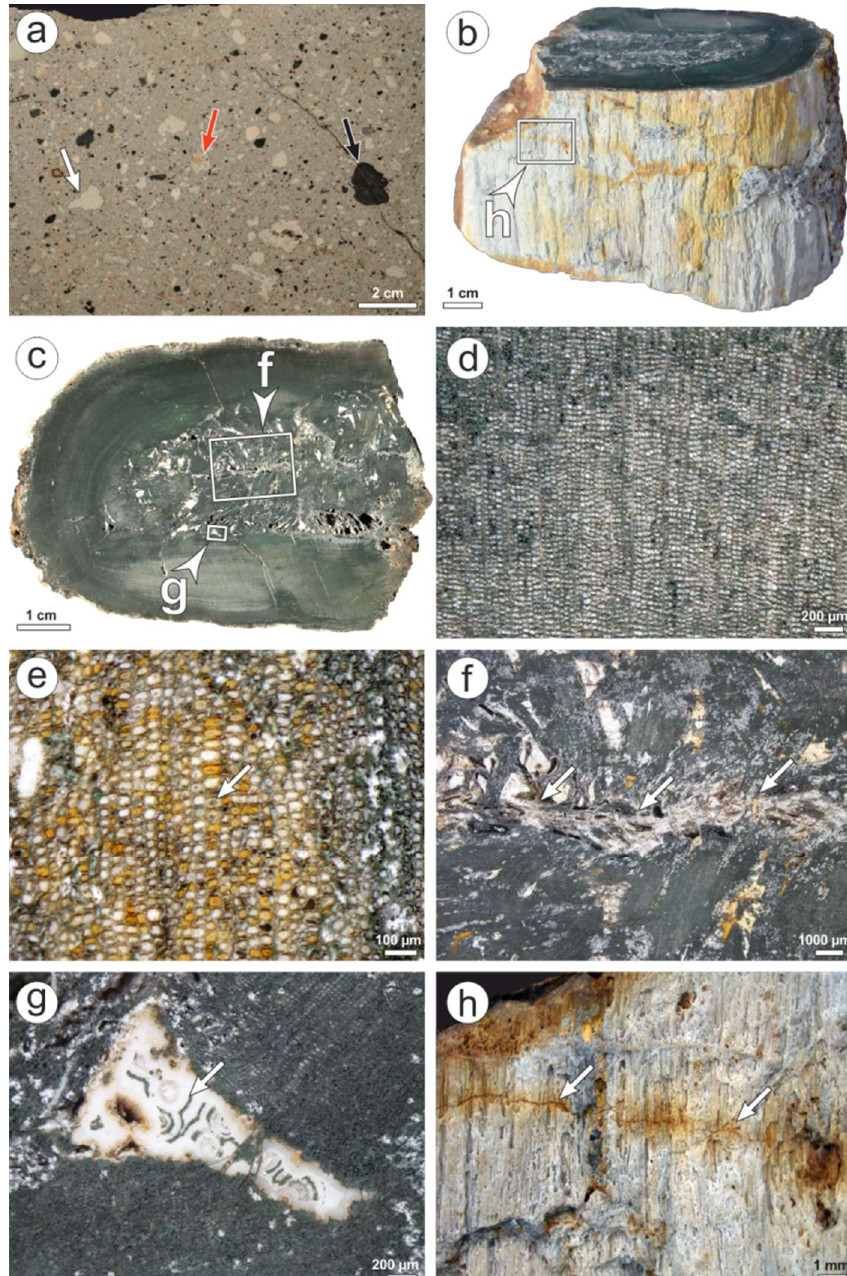
Figure 4. Features of K6563 and the Schweddey Ignimbrite from Flöha. ( a ) Schweddey Ignimbrite, containing carbonized plant remains (black arrow), weakly welded pumice (white arrow) and cm-sized feldspars (here plagioclase incorporating an orthoclase, red arrow). ( b ) Stem, from which K6563 is derived from. ( c ) Stem in cross section. Note the inner part of the stem showing abundant cavities filled by white agate. ( d ) Green-colored wood in cross section. ( e ) Close-up of the wood showing polygonal shapes of the tracheids in cross-section. Cell walls and parts of the cell lumina (arrow) are filled by a green mineral phase. ( f ) Close-up of the stem’s center. The former pith cavity is compressed to a white line (arrows). ( g ) Cavity filled by white agate. Note intercalations of a green mineral phase (arrow). ( h ) Limonite-bearing fractures (arrows) as pathways for oxidation caused by weathering.